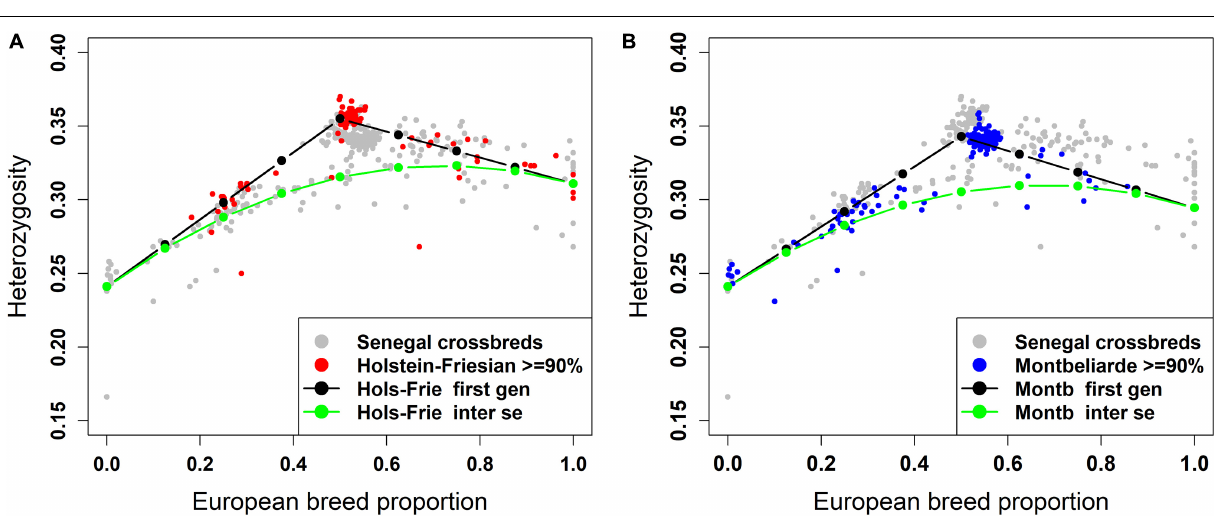
between crossbred animals of identical breed